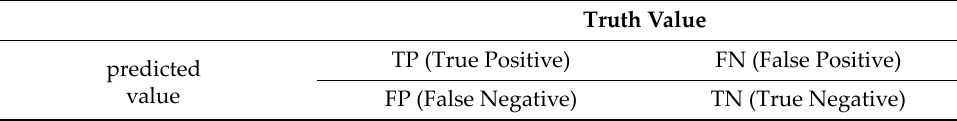
Table 2. Model index evaluation